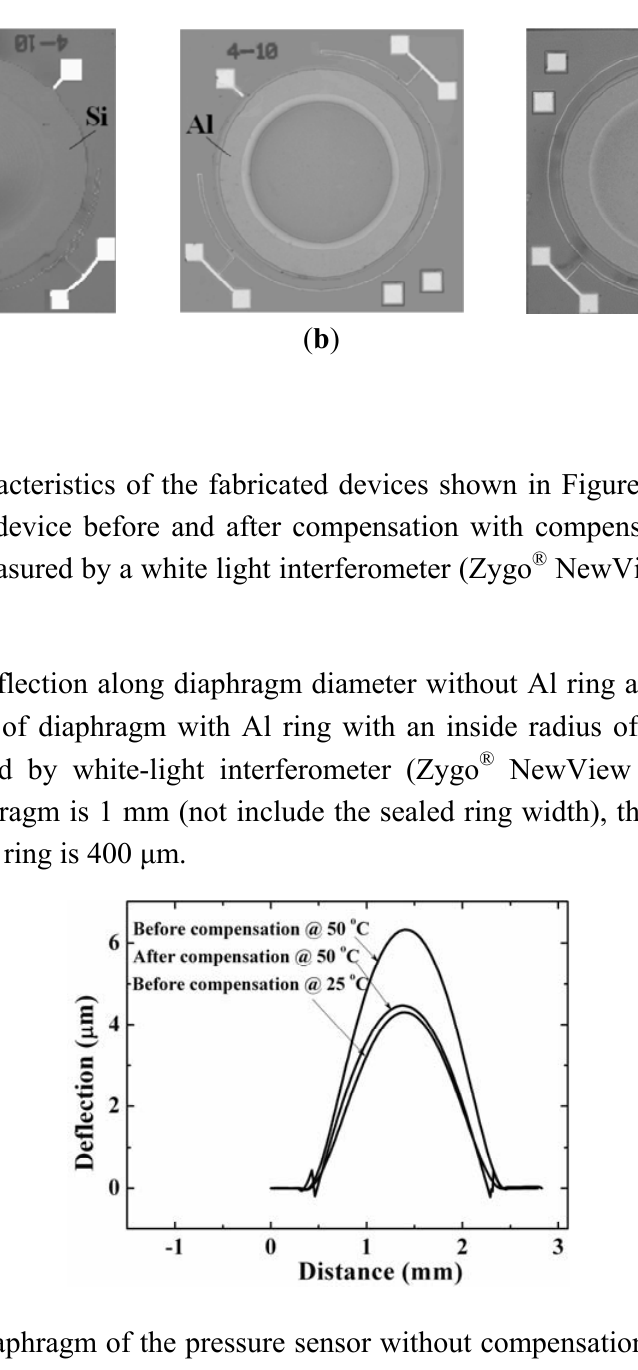
Figure 10. Micrograph photos of the fabricated devices: ( a ) no compensation ring; ( b ) compensation ring with an inside radius of 900 μ m; ( c ) compensation ring with an inside radius of 300 μ m.